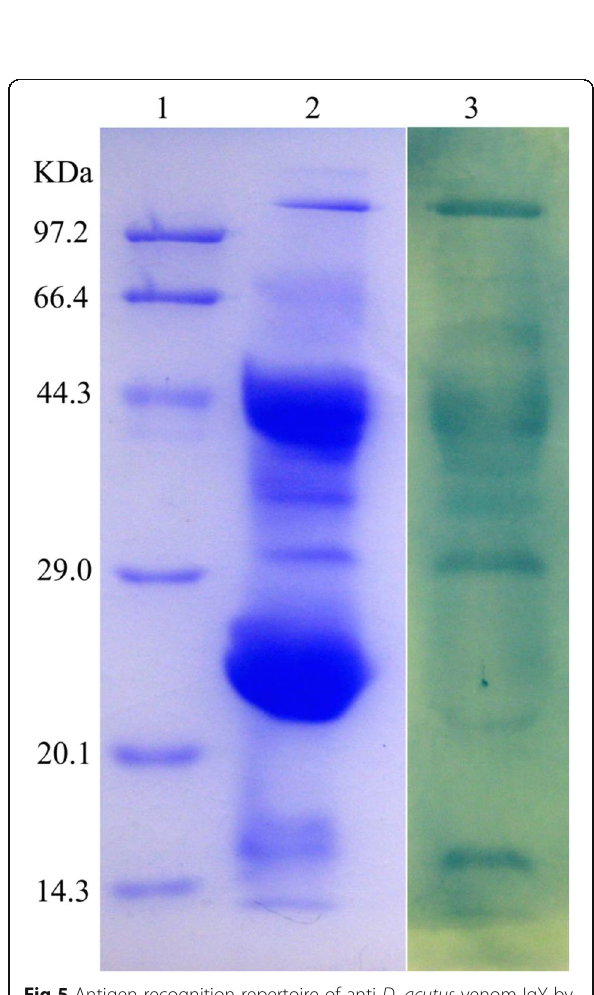
Fig 5 Antigen recognition repertoire of anti- D. acutus venom IgY by Western blot. Lane 1: Molecular weight marker on SDS-PAGE. Lane 2: D. acutus venom (50 μ g) on SDS-PAGE. Lane 3: the protein components of D. acutus venom (50 μ g) on Western blot were recognized by IgY that was recognized by HRP-rabbit anti-chicken